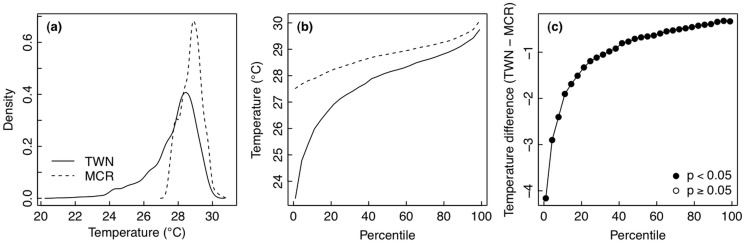
Comparison of seawater temperature between Moorea [MCR] and Taiwan [TWN].(a) Histogram of the frequency densities of temperature values observed during the deployments. (b) Distributions of frequencies of temperature values during the deployments. (c) Differences in temperature (TWN—MCR) for each percentile of the distribution of seawater temperature, tested whether different from zero using Monte Carlo randomizations.